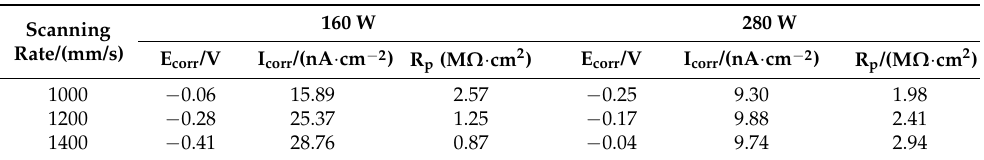
Table 2. Corrosion potential and current density of Ti6Al4V alloy in SBF at laser power of 160 W and 280